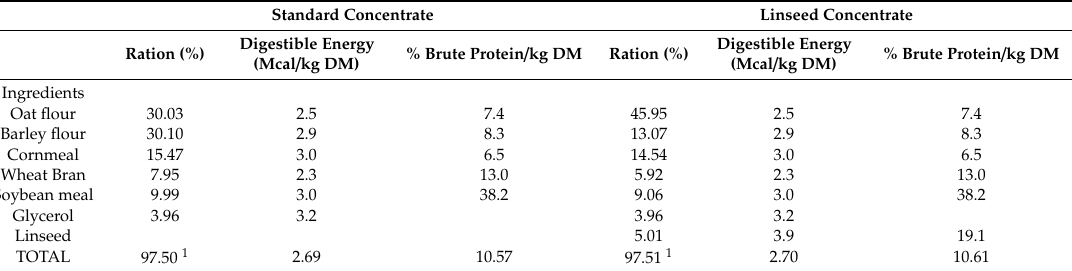
Table A1. Concentrates